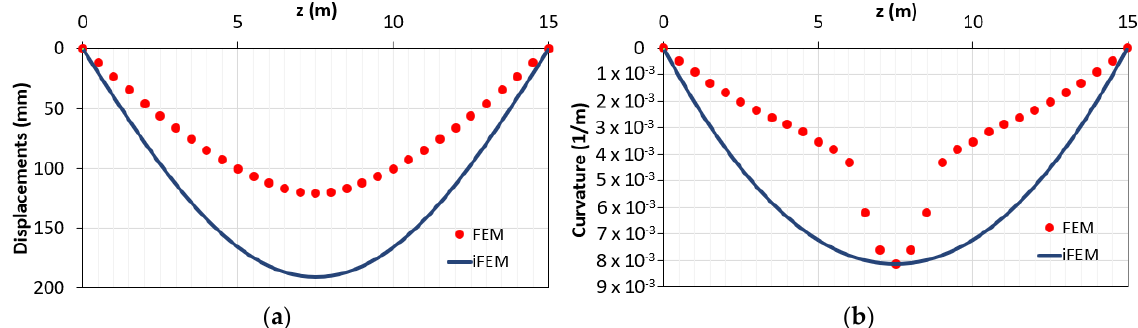
Figure 6. Yielded element modeled with one inverse element and three station points: ( a ) displacements diagram; ( b ) curvatures diagrams.